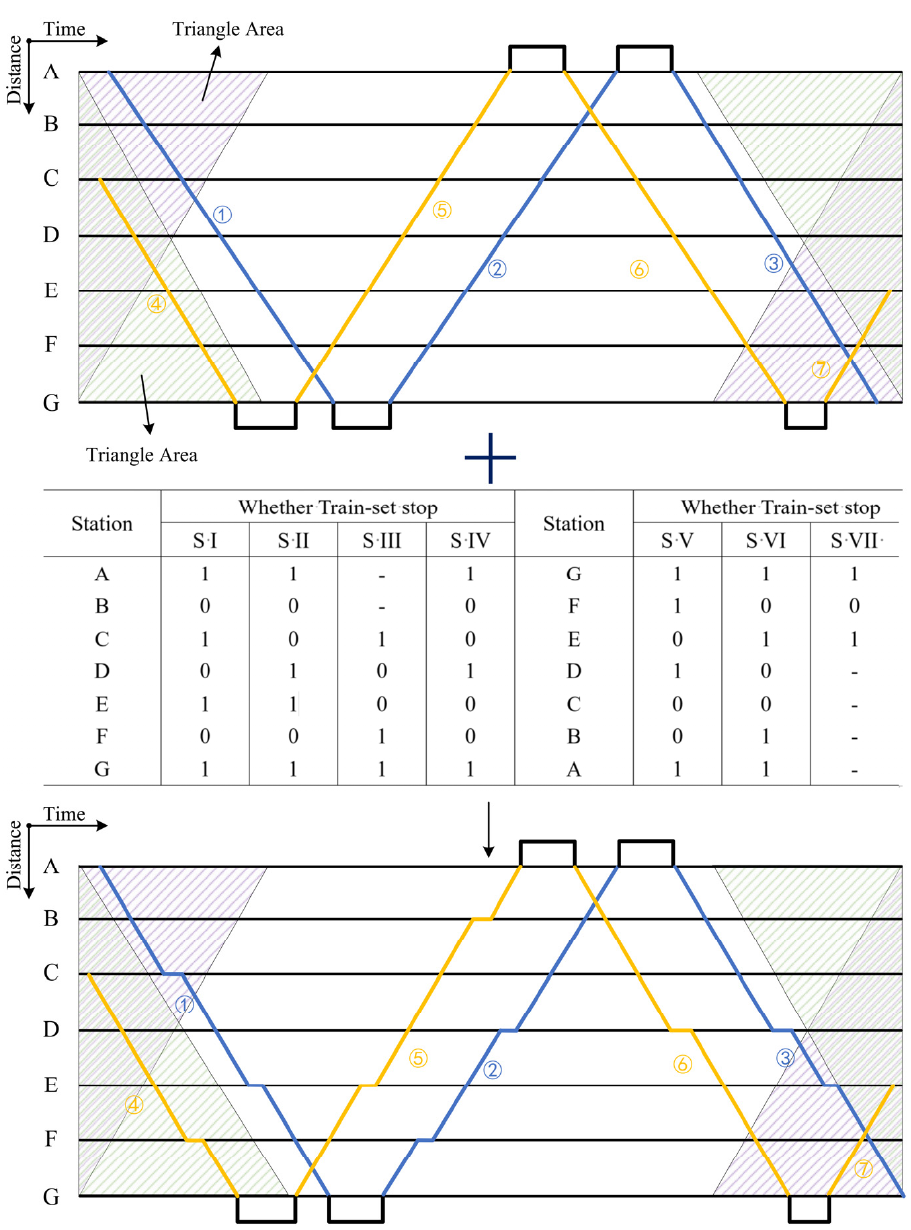
Figure 10. The schematic diagram of the method for splitting and matching.